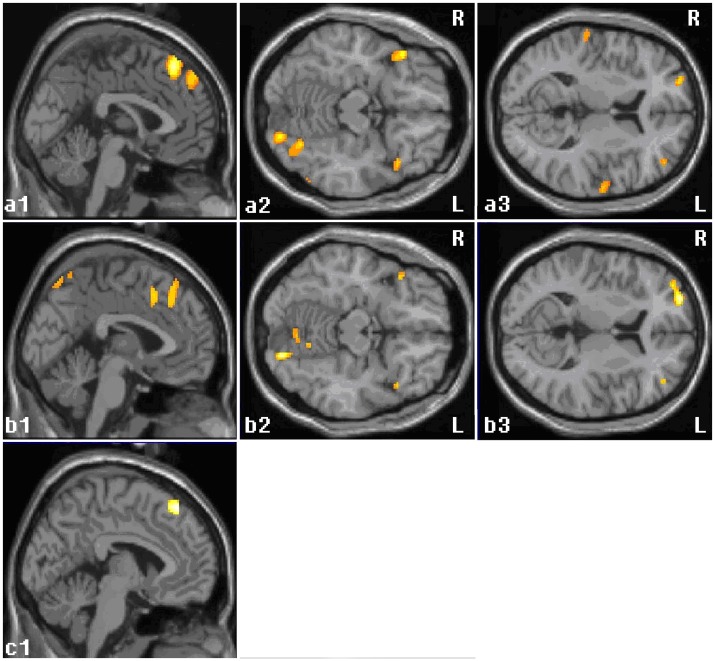
Activations related to the effect of expectancy interventions.a: Activations in EG vs. NE. b: Activations in Group A vs. Group B. c: Activations in Group C vs. Group D. In those three interventions, the left medial cortex, bilateral OFC and right posterior lobe of the cerebellum were activated (a1, a2, b1, b2, c1). In both EG vs. NE and Group A vs. Group B, bilateral DLPFC were activated (a3, b3). SPM maps the threshold at p<0.001 uncorrected. See Table 2 for details. EG: expectancy group (Group A with Group C). NE: no-expectancy group (Group B with Group D).